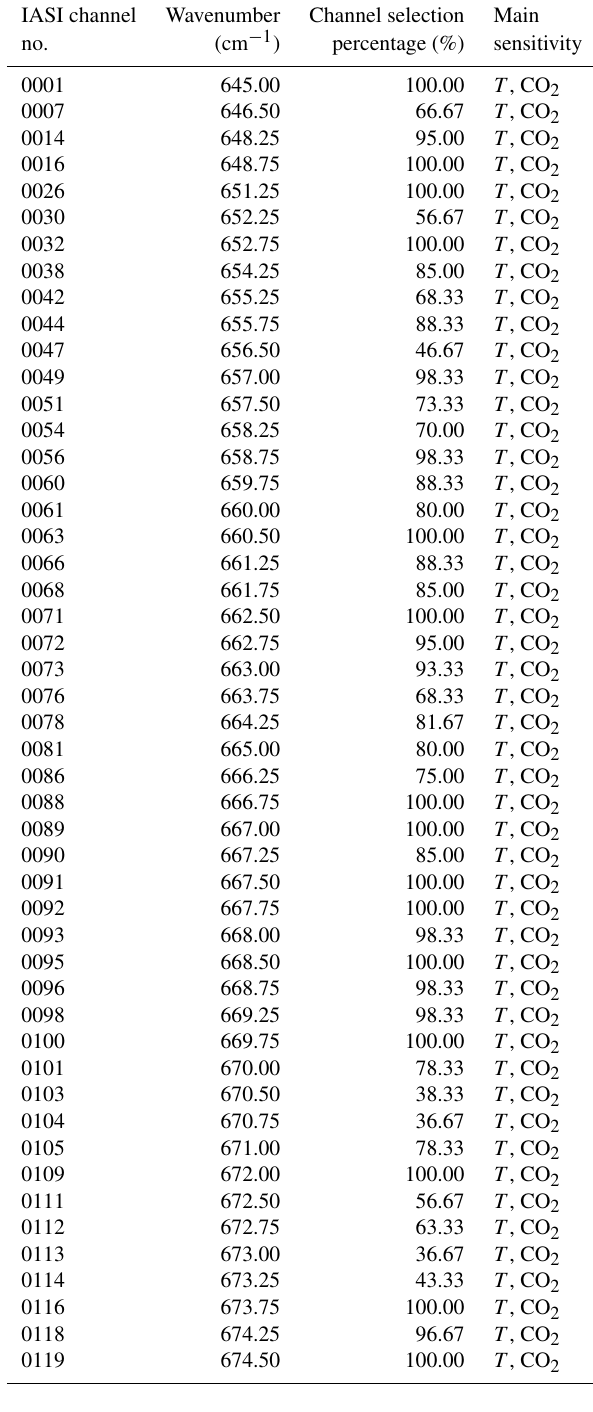
Table B1. List of 400 IASI channels selected using the method de- scribed in this